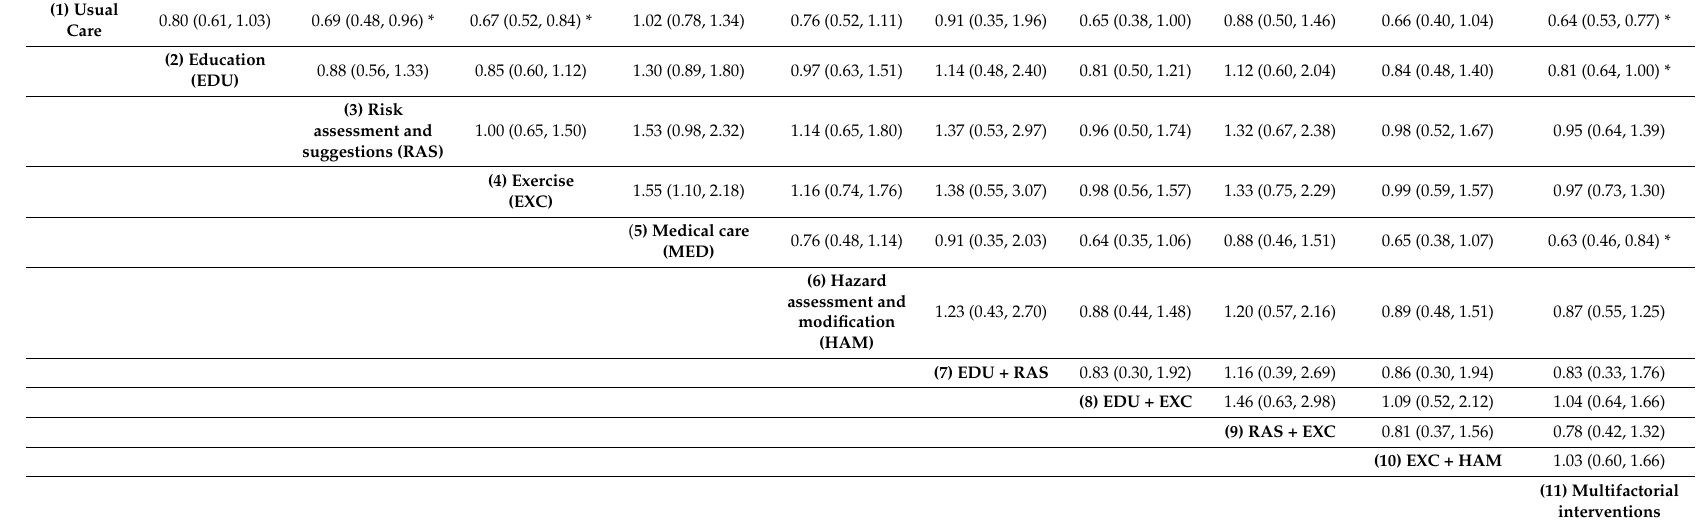
Table 1. Results of pooled odds ratios (95% CrI) for fall prevention interventions using Bayesian Hazard assessment and modification (NMA). (1) Usual